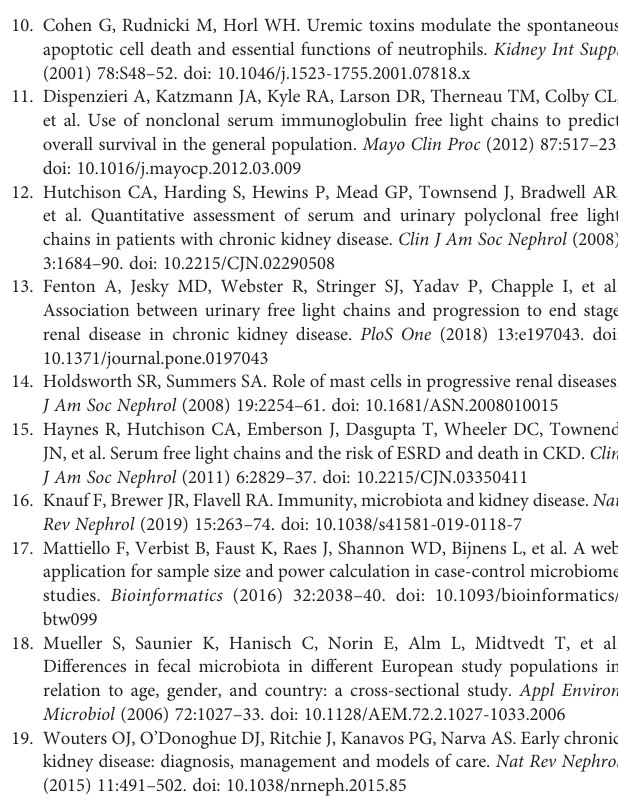
Supplementary Figure 1 | Principal coordinates analysis (PCoA) revealed clustering of bacterial taxa in the six stages of CKD based on Bray – Curtis distance, with each point corresponding to a subject and colored according to the sample type. Permutational multivariate analysis of variance showed that the separation of bacterial communities in the six stages was not signi fi cant ( P > 0.05). Supplementary Figure 2 | Bacterial taxon abundance showing a signi fi cant difference between the CKD and HC groups without adjusting confounders ( P < 0.05). The Wilcoxon rank-sum test was used to compare differences in abundance between the two